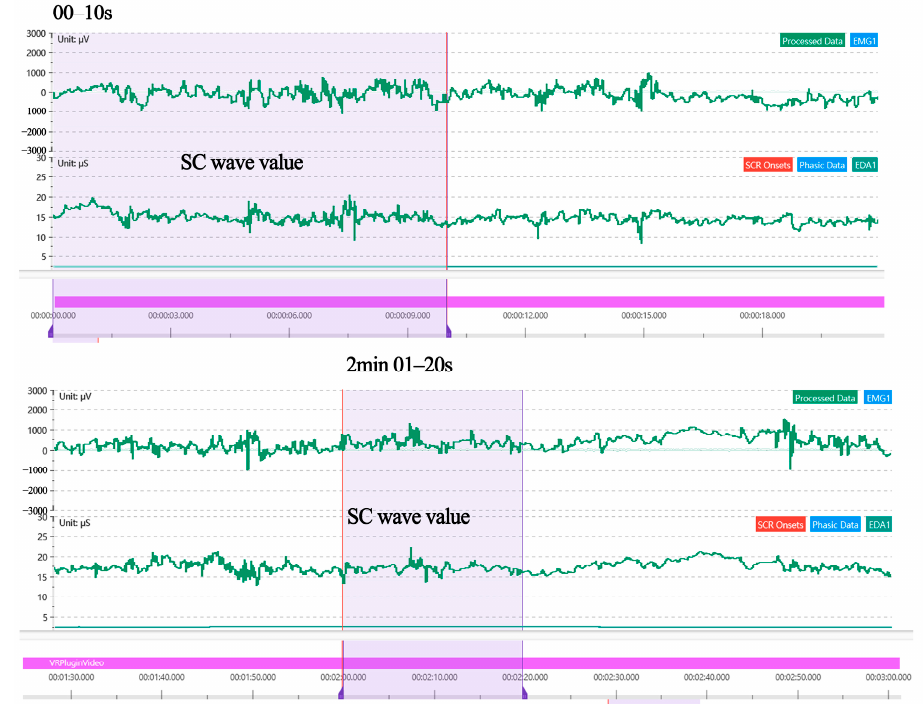
Figure 4. The skin conductance wave value response. Source: The emotional arousal state between 0–10 s and 1–20 s of 2 min was intercepted to calculate the skin conductance range of the subjects.